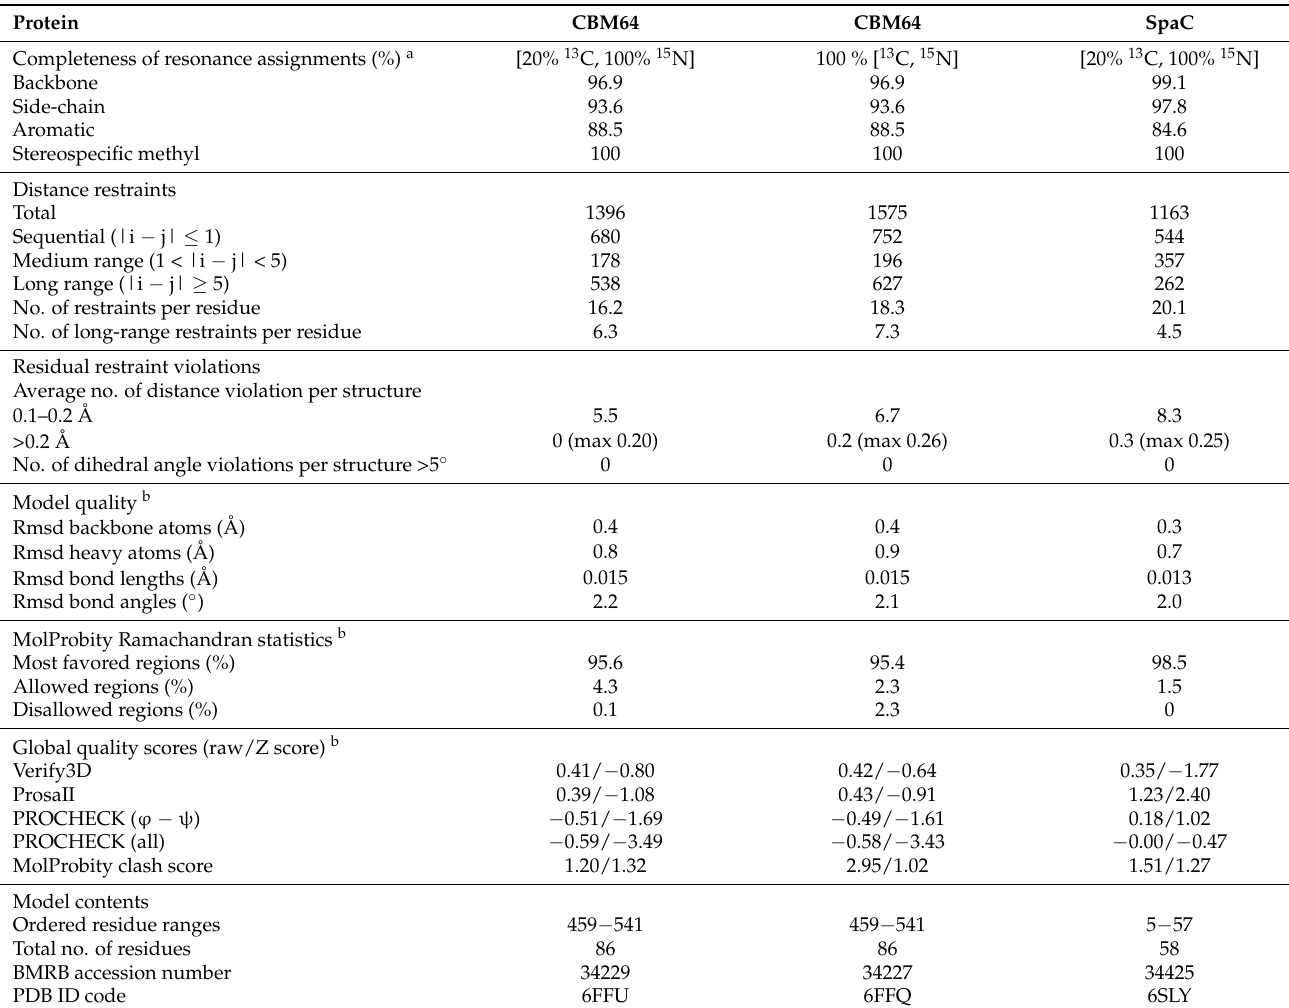
Table 1. Structural Statistics for the 20 Energy-Minimized NMR Conformers of CBM64 and